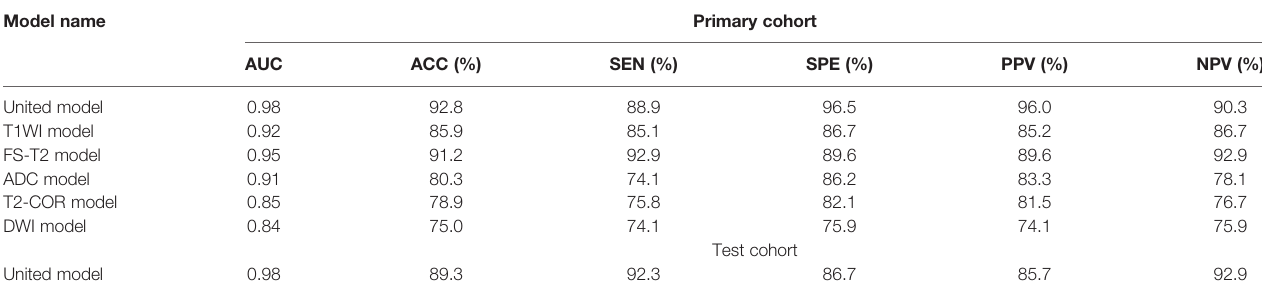
TABLE 3 | Performance of each model in primary cohort and test cohort. Model name